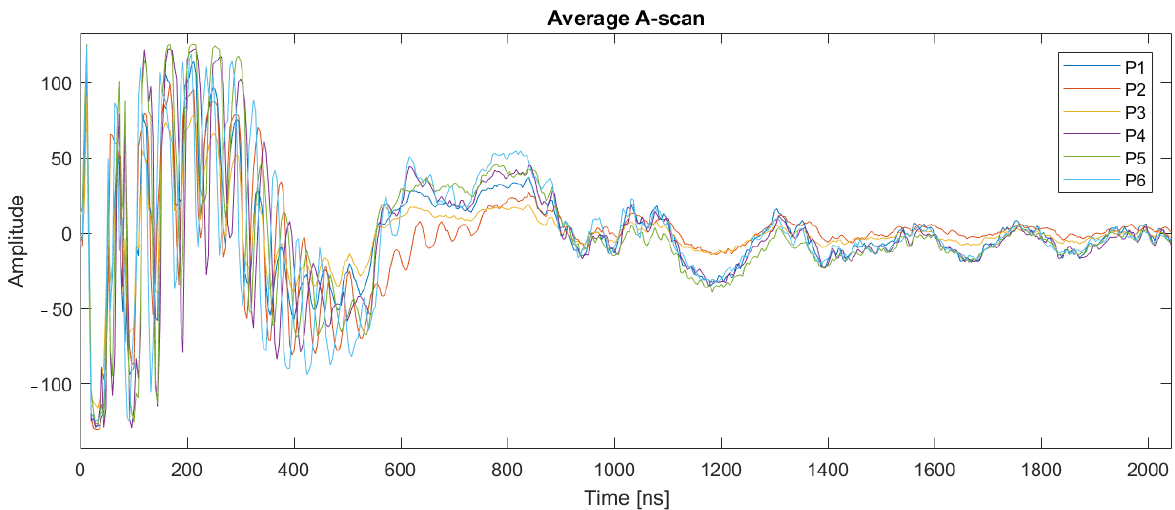
Figure 9. Superposition of the average A-scans.